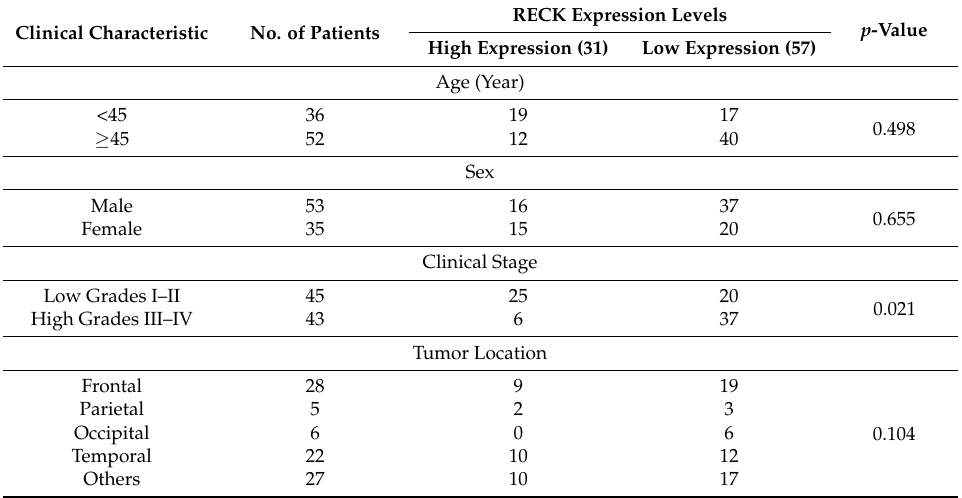
Table 1. Correlation between RECK expression and clinicopathological features of glioma patients. Clinical Characteristic No. of Patients